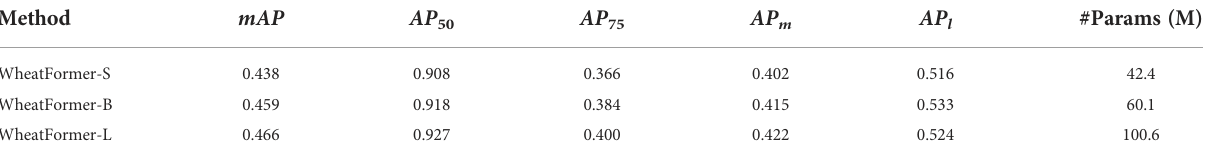
TABLE 6 Comparison of variant models.